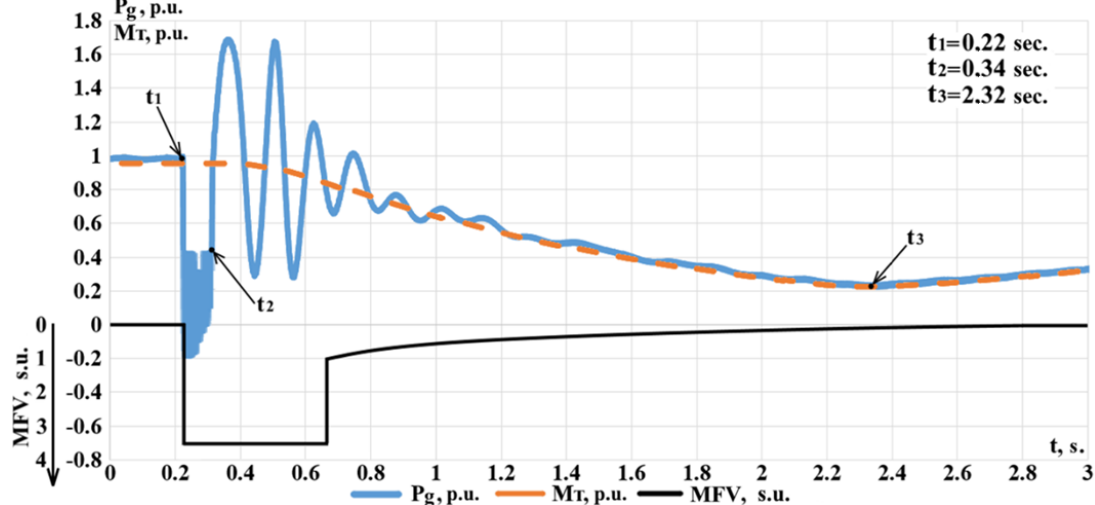
Figure 13. Generator G 2 active power and turbine torque for a case of FV ( A i = 4 pu).